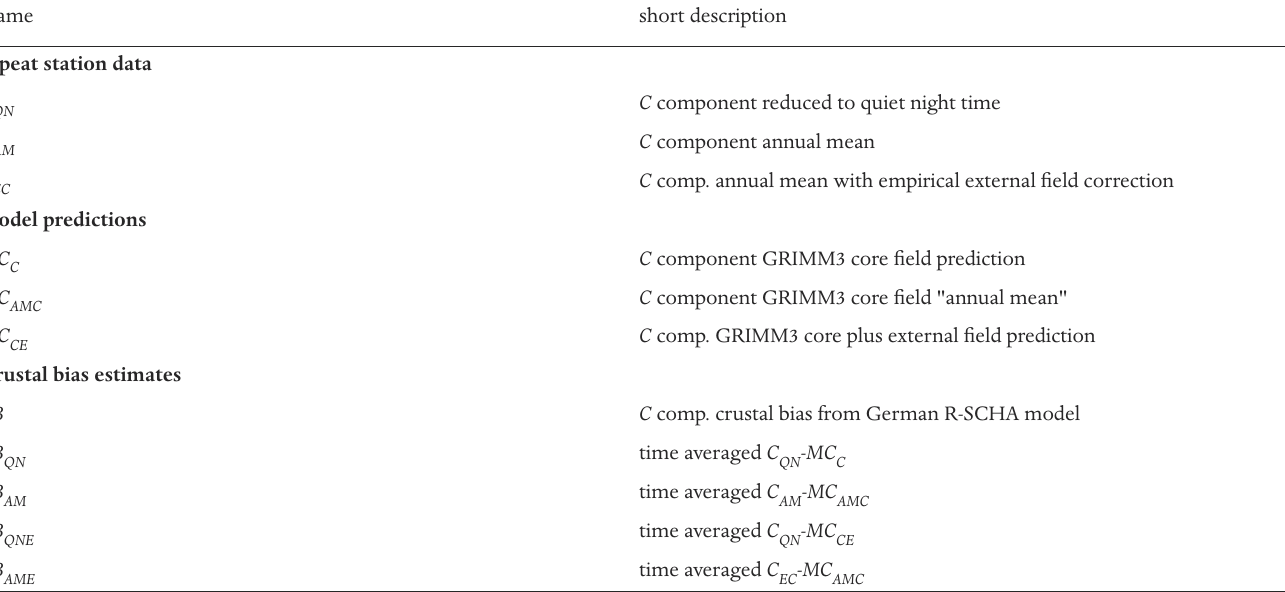
Table 1. Summary of data, model predictions and results